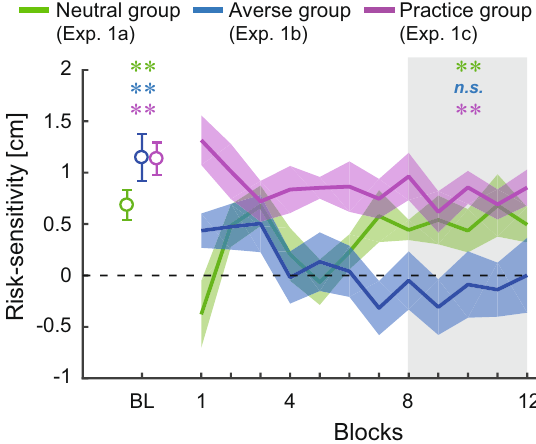
Figure 5. Achievement of risk-neutrality influenced by the opponents. Risk-sensitivity values, defined as the difference between the mean endpoint and optimal endpoint, are plotted. BL denotes the risk-sensitivity for 5 blocks of the individual task (baseline). Each block denotes the risk-sensitivity for each block of the competitive task (risk-neutral and risk-averse groups) or for each block of the individual task after the baseline (practice group). The shaded gray area highlights the last five blocks. Data is averaged across subjects, and the shaded area denotes the standard error of the mean. Positive values indicate a risk-seeking strategy, whereas negative values indicate a risk-averse strategy. Green, blue, and magenta asterisks denote p < 0.01 from the risk-neutral value (i.e. 0) for the risk-neutral, risk-averse, and practice group, respectively. At the baseline, the risk-seeking strategy was taken in all groups. This trend was consistent in the practice group and partially modulated in the risk-neutral group. In the risk-averse group, the sub-optimal risk-seeking strategy was improved to risk-neutral. Notably, in the risk-averse group, there was no significant difference in the last 50 trials of the competitive task (shaded gray area). Between-group comparison of risk-sensitivity values is shown in Supplementary Fig. 5.